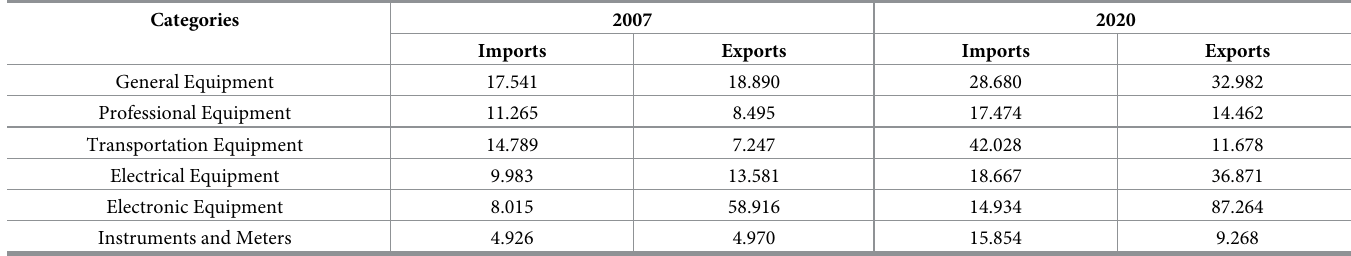
Table 1. China-EU import and export trade structure in equipment manufacturing industry (unit: Billion US